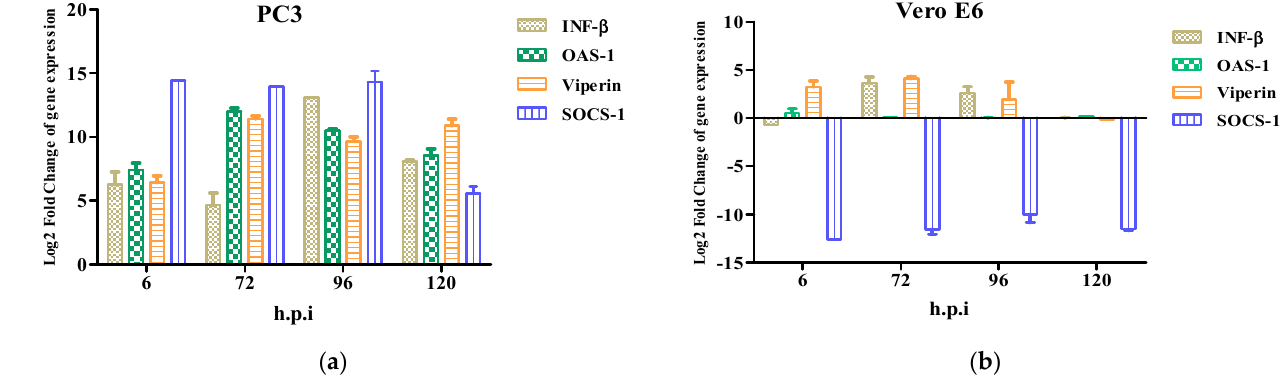
Figure 4. ZIKV replicates in PC3 cells. Viral kinetics was determined in PC3 ( a , b ) and Vero E6 ( c , d ) cells infected at an MOI = 1 at 0–120 h.p.i, and 0 h.p.i corresponds to viral input. Characterization of the replicative cycle was established by plaque-forming units ( a , c ) and quantification of viral genomes ( b , d ). Analysis shows mean and SEM from independent experiments.